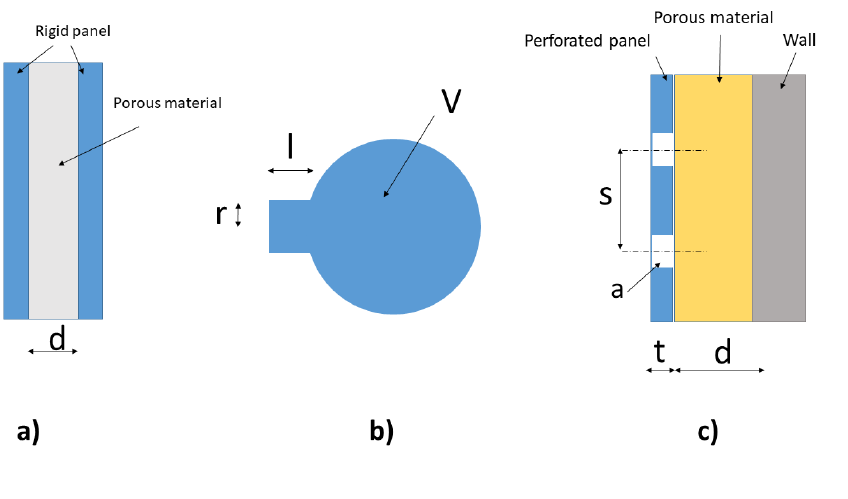
Figure 3. Representation of ( a ) a double partition made of two rigid leafs with an internal porous layer, ( b ) Helmholtz resonator and ( c ) mixed system—multiple